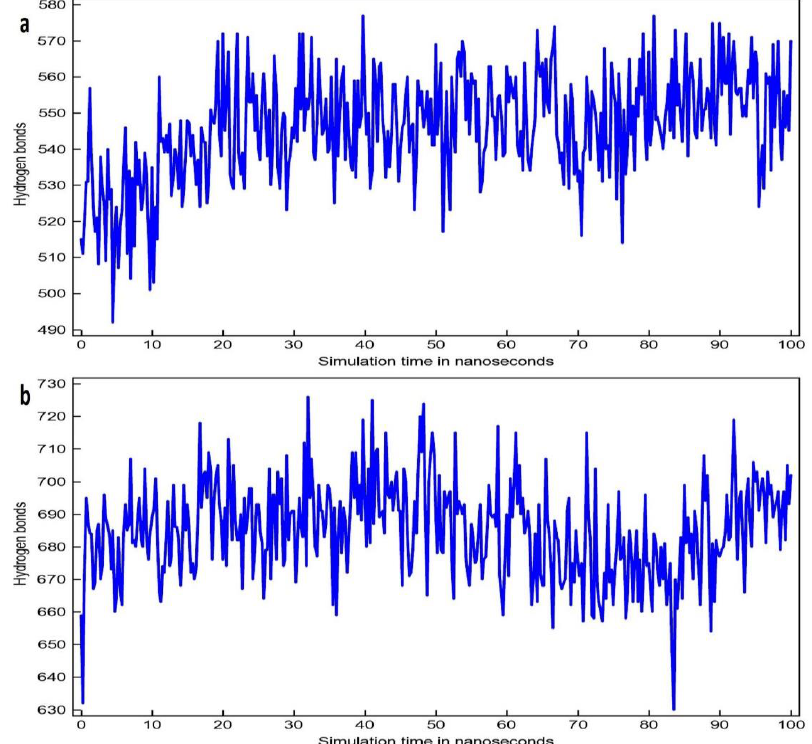
Figure 7. Number of hydrogen bonds for ( a ) DTQ-3CLpro complex and ( b ) DTQ-NSP15 with respect to the simulation time of 100 ns.